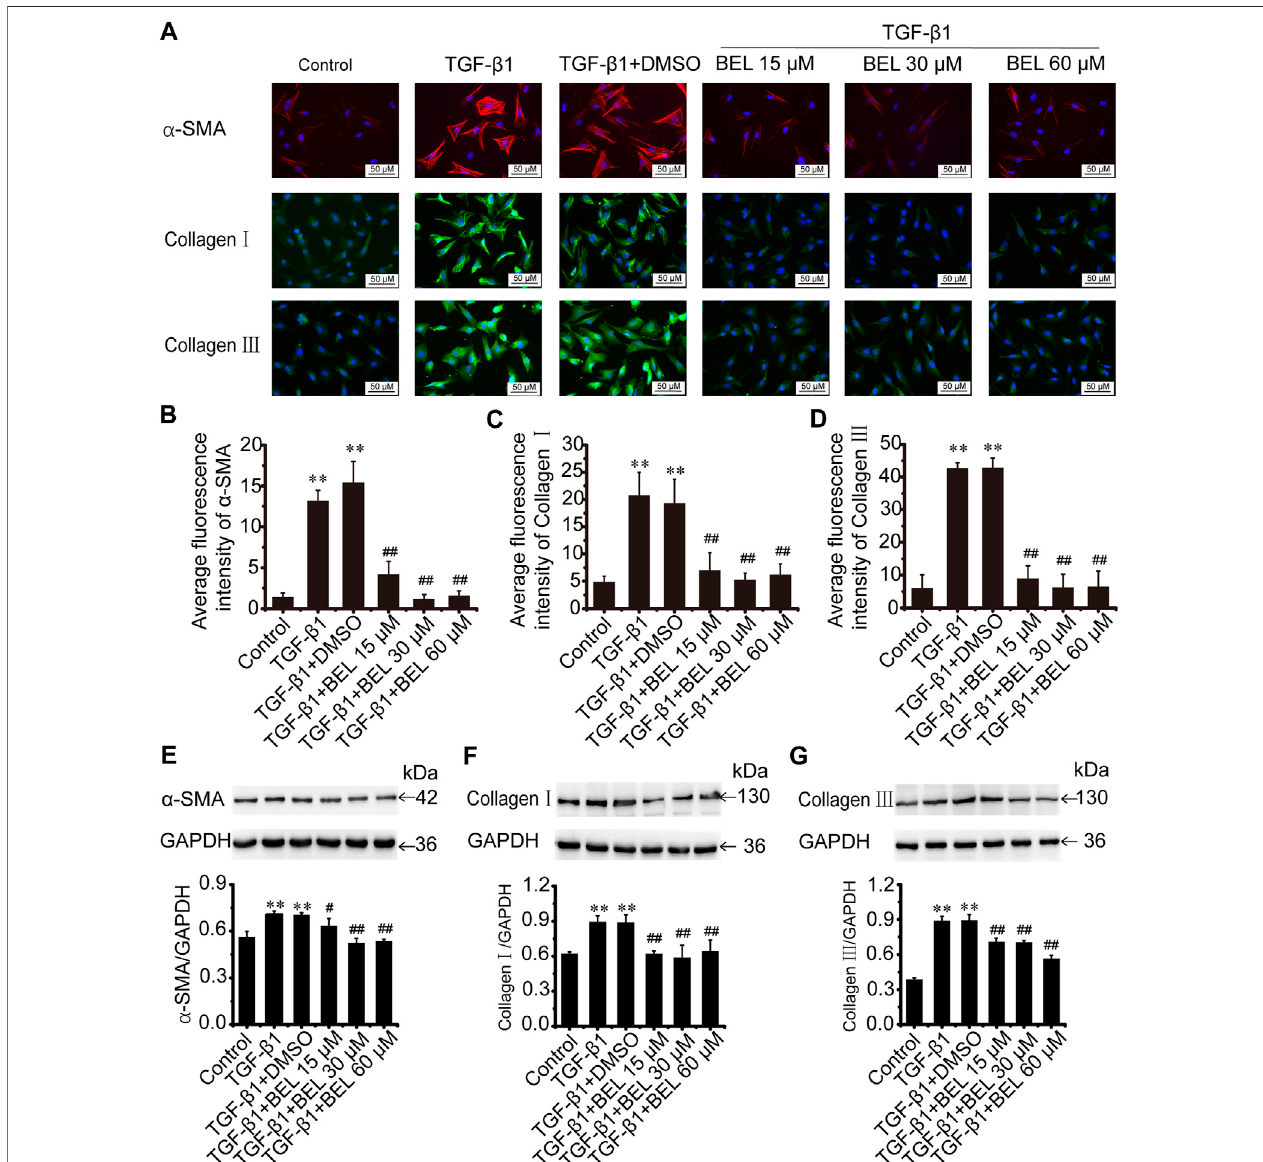
FIGURE4| BELdecreasestheexpressionof α -SMA,collagen Ⅰ ,andcollagen Ⅲ inducedbyTGF- β 1inCFs (A) TheeffectsofdifferentdosesofBEL(15,30,60 μ M) on α -SMA, collagen Ⅰ , and collagen Ⅲ expression induced by TGF- β 1 using immuno fl uorescence staining. Cell nuclei was counterstained in blue with DAPI (B – D) Bar graphs show quantitative analyses of fl uorescent signals for α -SMA, collagen I and collagen III (E – G) Western blotting detects the expression of α -SMA, collagen Ⅰ , and collagen Ⅲ expression. Bar graphs show fold changes of α -SMA, collagen Ⅰ , and collagen Ⅲ expression as analyzed by western blotting. GAPDH was used as a loading control ( n (cid:2) 3). Data were shown as mean ± SEM. ** p < 0.01 vs. control, # p < 0.05 vs. TGF- β 1, ## p < 0.01 vs. TGF- β